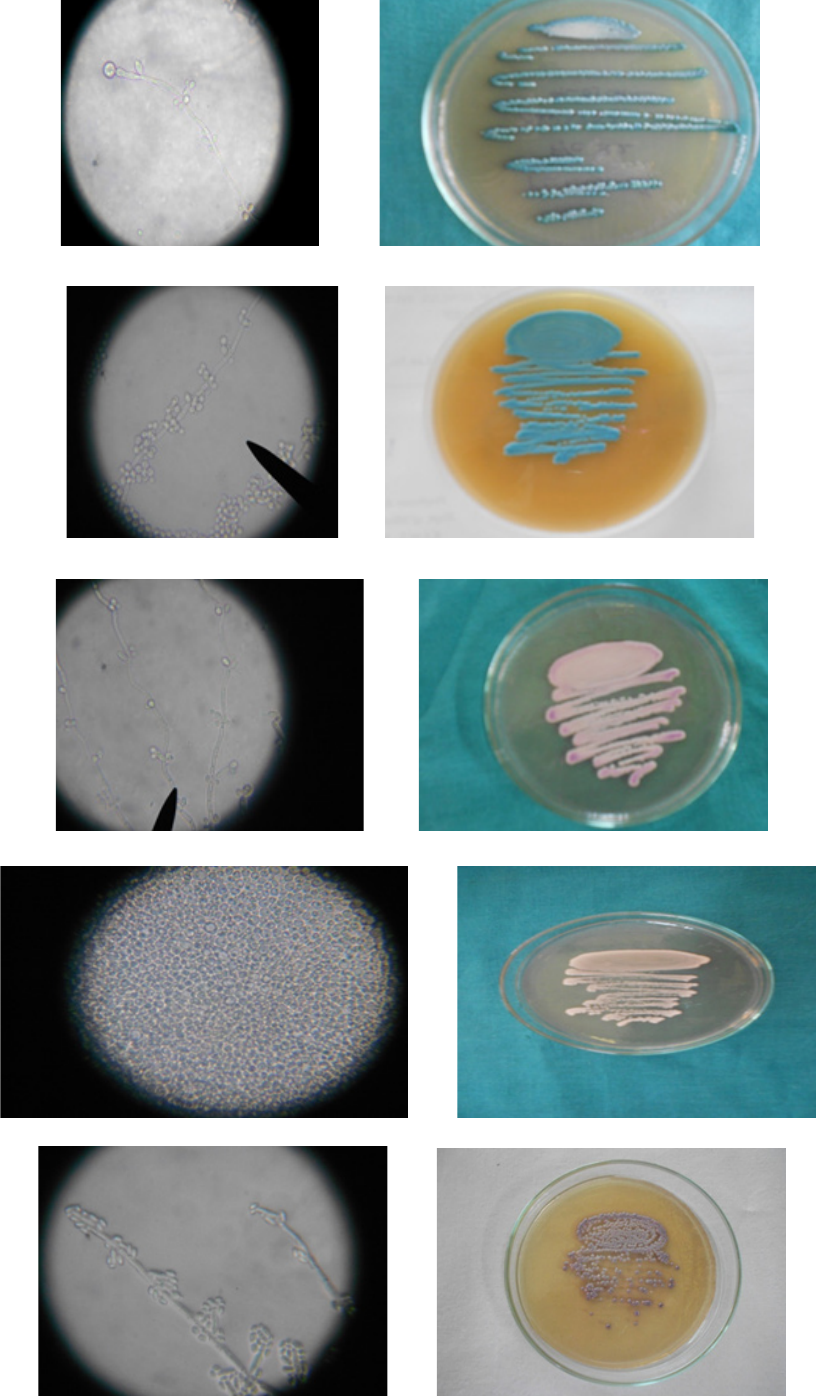
Fig. 1. Microscopic appearance on corn meal agar ( left; magnification ,x400) and colony colors on Hicrome agar for candida after 48 hours of incubation. (A) C albicans (B) C. tropicalis (C) C. parapsilosis (D) C. glabrata (E) C.